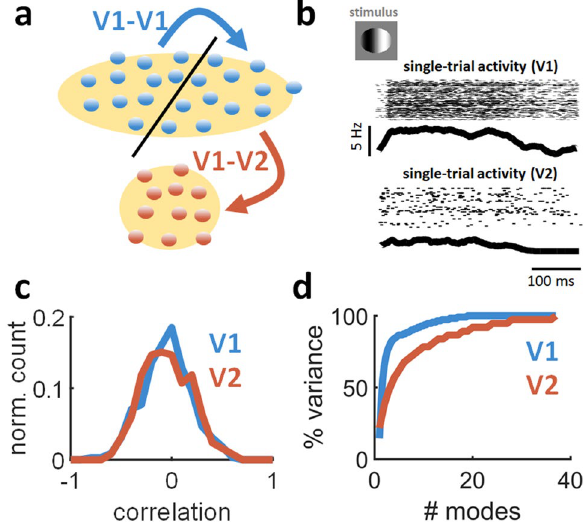
Figure 6. Analysis of feedforward interactions in cortical areas V1 and V2. ( a ) Simultaneously recorded V1 neurons were split into two even groups whose size matched the number of units recorded in V2. This arrangement of the data allowed for analyses of both V1-V1 and V1-V2 interactions. ( b ) Example of single- trial activity in simultaneous recordings of V1 and V2 neurons in response to oriented stimuli. Top: spike raster across all neurons. Bottom: summed population activity smoothed using a 100 ms rolling window. ( c ) Distribution of pairwise correlations within cells of V1 and V2, respectively. ( d ) Variance explained by neural modes of V1 and V2 activity across all